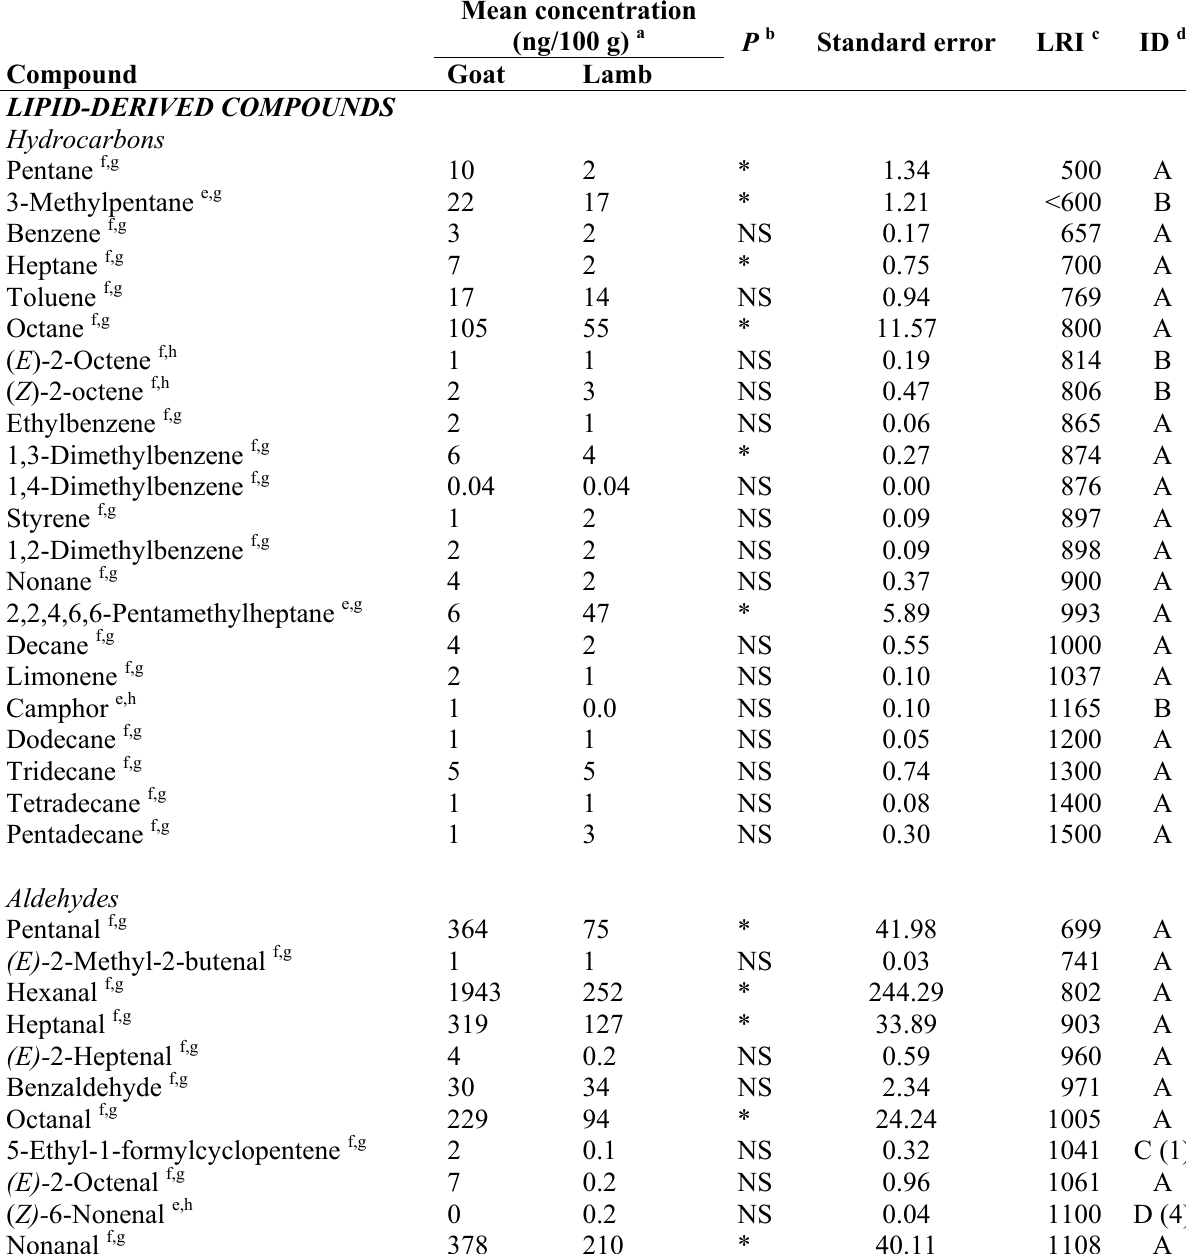
Table 3. Volatile compounds in the headspace of the grilled Longissimus dorsi from Saanen goat and cross Suffolk